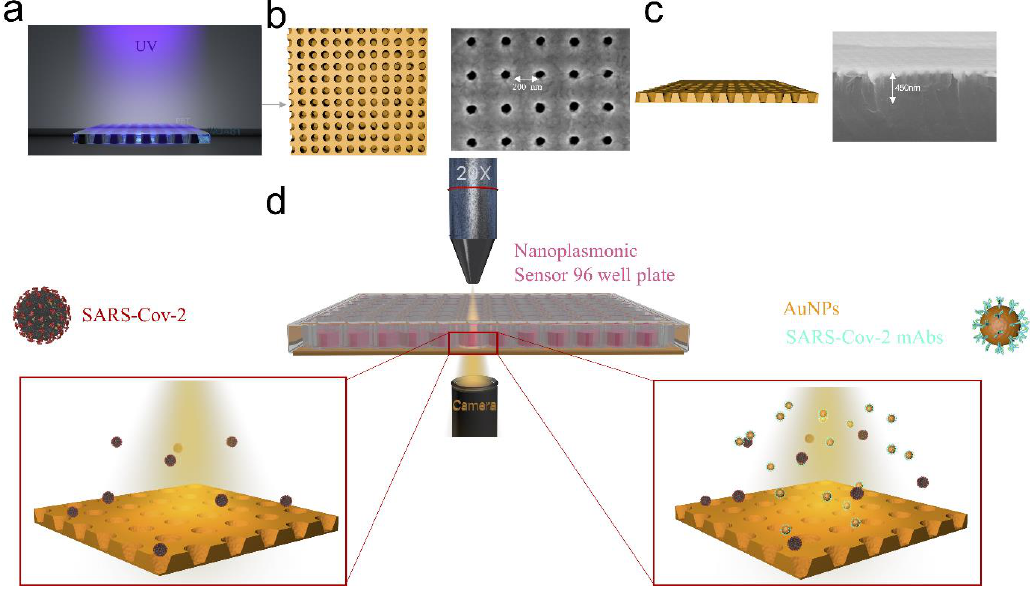
Figure 1. Schematic of SARS-CoV-2 detection with plasmonic sensor chip under the microscope . ( a ) Schematic of the fabrication of Au-TiO 2 -Au nanocup array chip sensor. Spread UV-curable polymer (NOA61) on the PET sheet, solidify the NOA61 on the PET sheet through UV irradiation, deposit metal on the surface of the NOA61 (left). ( b , c ) SEM images of the top view of the chip, SEM images of the cross-sectional view of the chip. ( d ) Acquire the microscope image of the chip after adding the SARS-CoV-2 virus (left) and acquire the microscope image of the chip after adding the detection antibody (right).